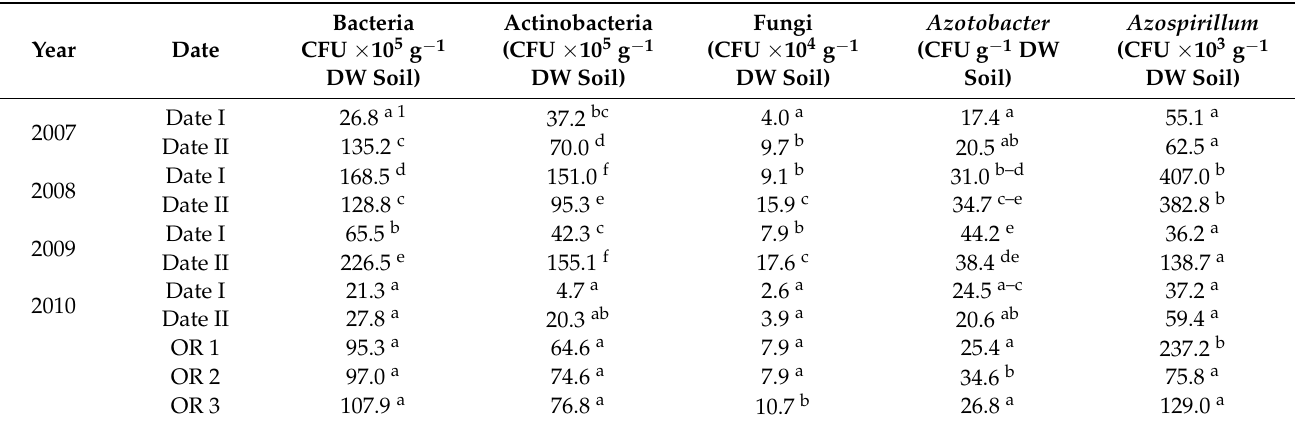
Table 7. Influence of the date of sampling and sour cherry orchards on the number of microorganisms in the soil during the vegetation season 2007–2010.